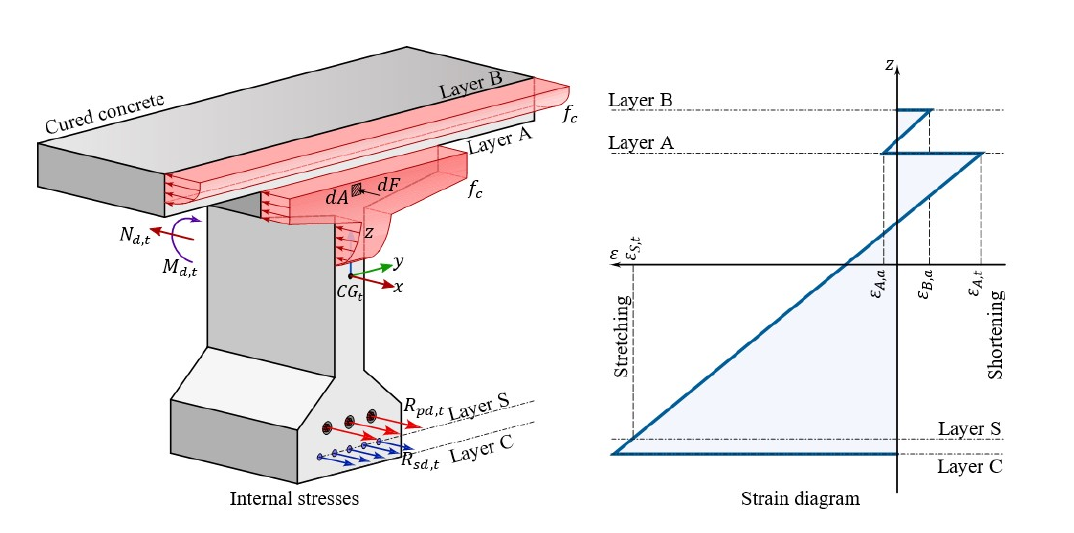
Figure 4. Internal stresses and strain diagram in total